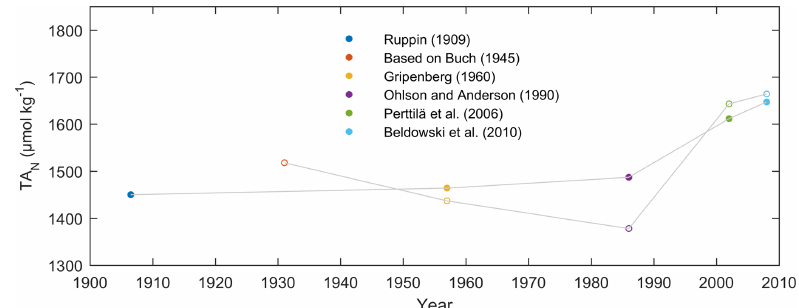
Figure 8. TA concentrations normalized to salinity = 7 (TA N ), using the TA–salinity relations for the Baltic Proper – Kattegat (full circles), and Baltic Proper – Gulf of Bothnia (open circles) (see Tables S7–S8, Supplement). The Ruppin (1909) value was based on measurements in 1906–1907 (see Dyrssen, 1993), while the Buch (1945) value was based on measurements in 1927–1935 (see Buch, 1945). The Buch (1945) and Perttilä et al. (2006) values were converted to micromoles per kilogram from micromoles per liter.